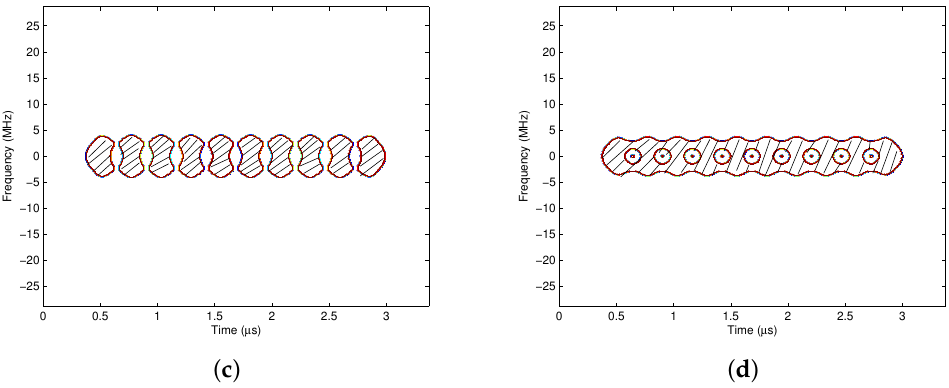
Figure 13. The pass regions with different window lengths. ( a ) The pass region with L h = 10; ( b ) The pass region with L h = 20; ( c ) The pass region with L h = 30; ( d ) The pass region with L h = 40.